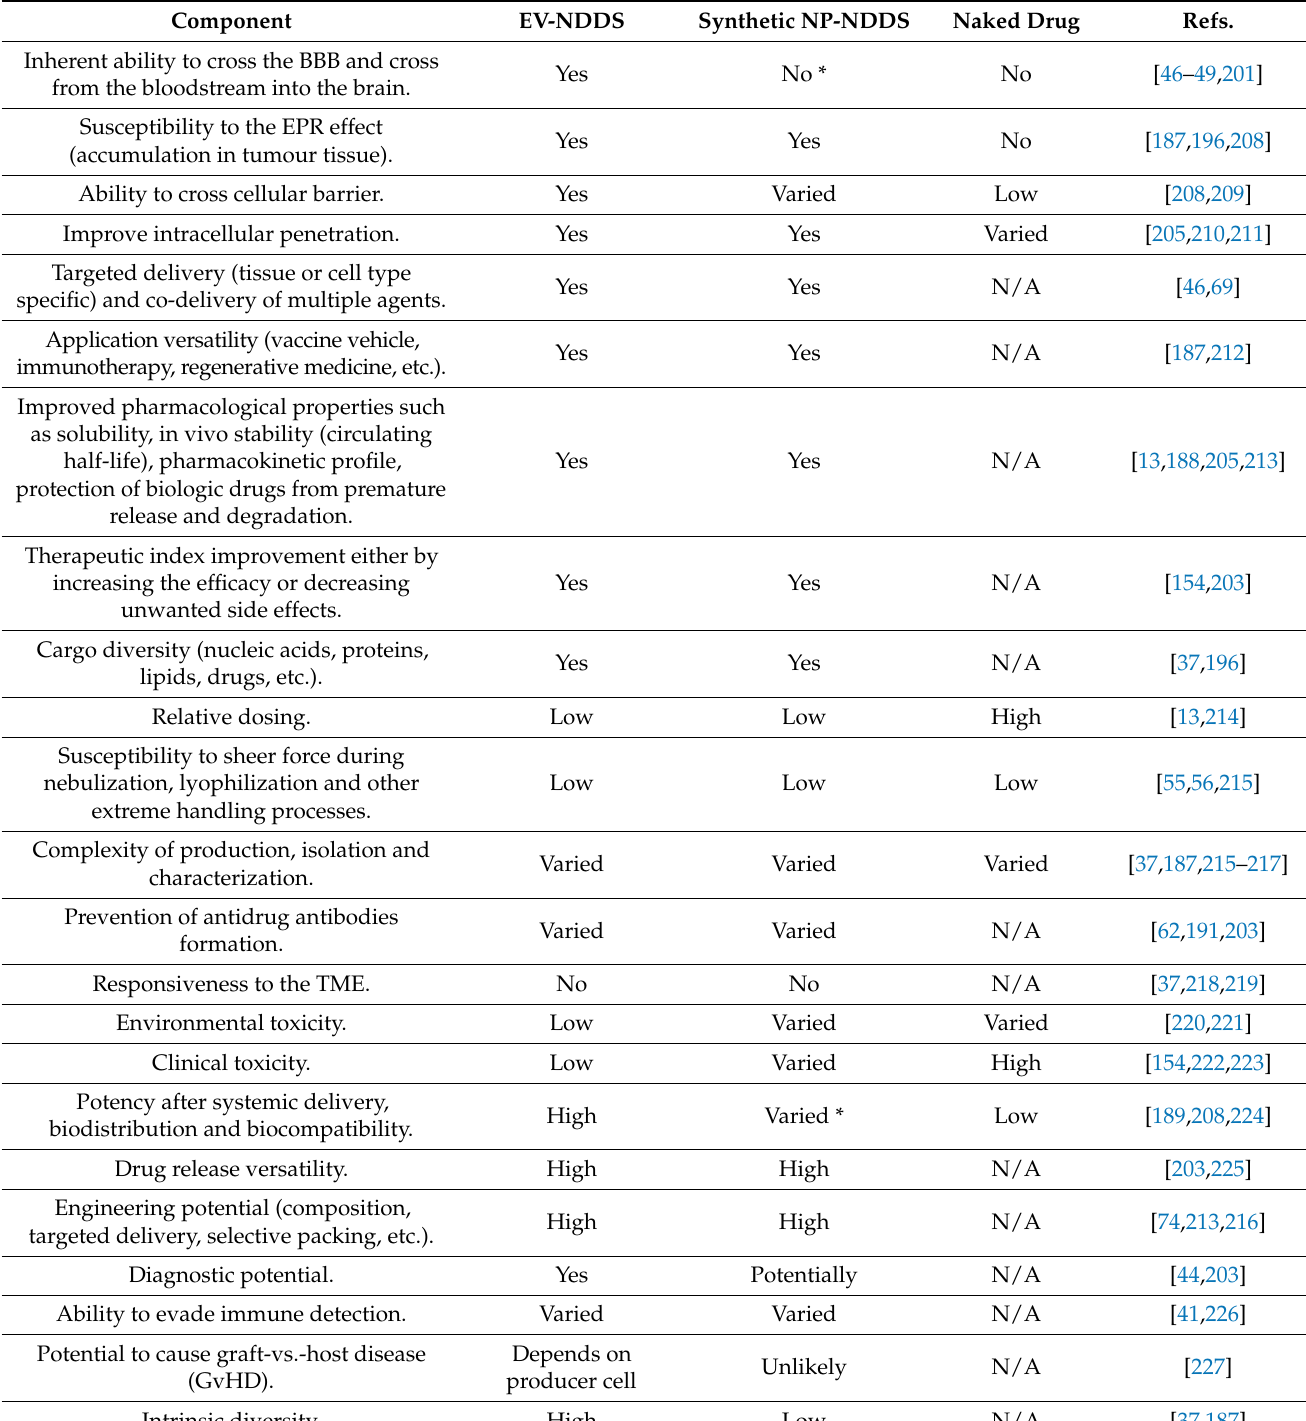
Table 4. A comparison between EV-NDDS, synthetic NP-NDDS and naked drug delivery systems. EV-NDDS Synthetic NP-NDDS Naked Drug